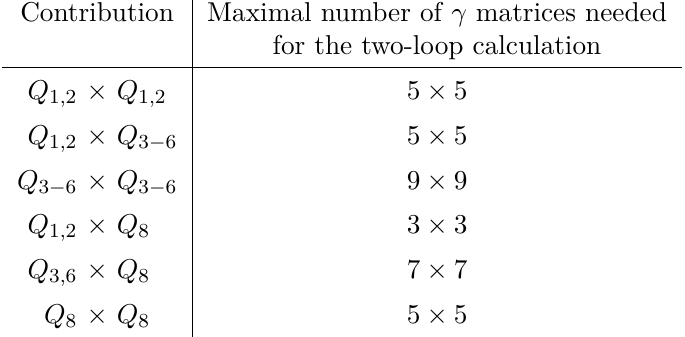
Table 1. Maximal number of γ matrices which appear in the calculation of two-loop corrections to the various contributions involving current-current and penguin